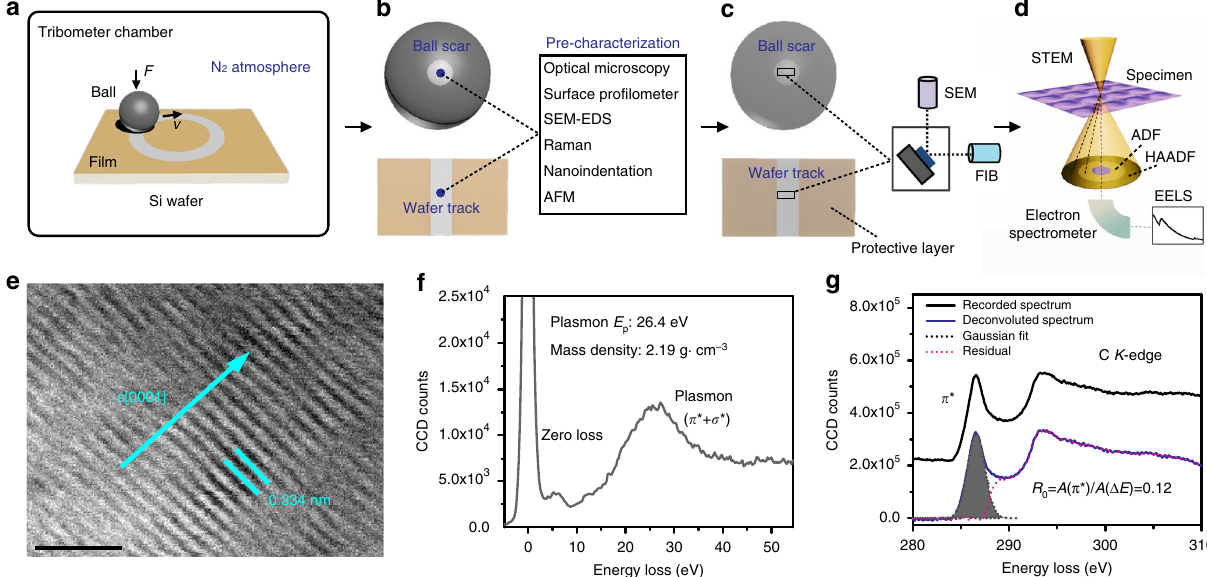
Fig. 1 Methodology. a – d Schematic diagrams of the experiments. a The experimental setup for ball-on-disc friction tests in a dry N 2 environment. b Various pre-characterizations of the produced contact areas including the ball wear scar and the wafer wear track after the friction tests as shown in a . c Dual beam SEM-FIB lift-out preparation of nanometer-thick lamellar specimens for TEM and STEM observations. Before FIB milling, the contact areas were protectively coated by a layer of Au or Cr with thickness measured in a few tens of nanometers. d STEM and EELS characterization of the FIB-fabricated lamellar specimens from the contact areas. e – g EELS quanti fi cation of highly oriented pyrolytic graphite (HOPG, 100% sp 2 -C bonds) as a standard for calculations of π * and σ * bonding fractions in the C K -edge spectra measured from the contact area. e BF-STEM image showing the lamellar structure of HOPG with a lattice distance of 0.334 nm along the c -axis. Scale bar, 2 nm. f Recorded zero-loss and low-loss plasmon spectrum of HOPG. The mass density was calculated to be 2.19 g · cm − 3 by measuring the energy E p of the plasmon peak. g Recorded C K -edge spectrum of HOPG showing a sharp π * peak and Gaussian fi t to the π * peak after background subtraction and deconvolution of the C K -edge spectrum. Normalizing the π * peak area to the integrated area within the energy window of 280 – 310 eV yields a standard value of 0.12. The measured peak ratio for a C K -edge spectrum referenced to this standard value fi nally yields the sp 2 fraction in the unknown